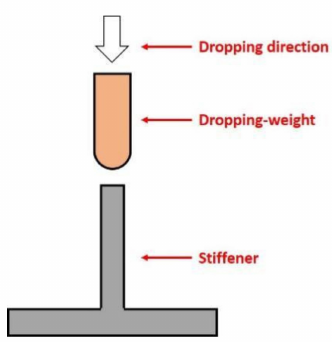
Figure 1. On-edge impact